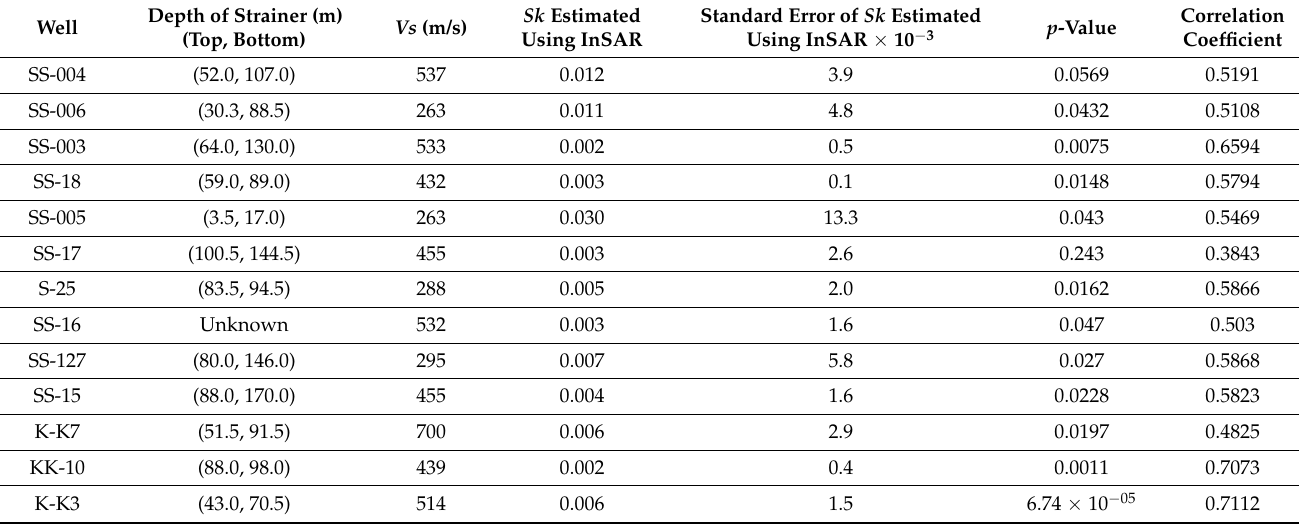
Table 1. Depth of strainer, Vs , estimated storage coefficient, its standard error, p -value, and correlation coefficient of the confined aquifer at 13 well